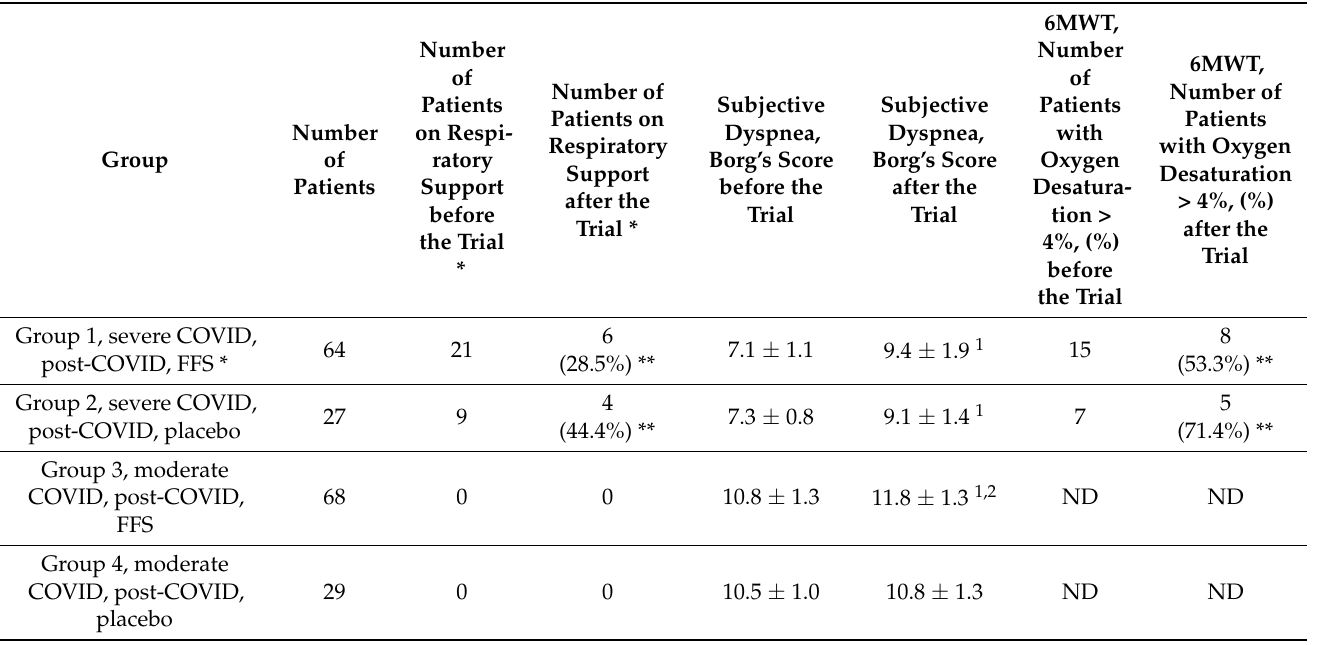
Table 5. Dyspnea (subjective) and tolerance to physical load